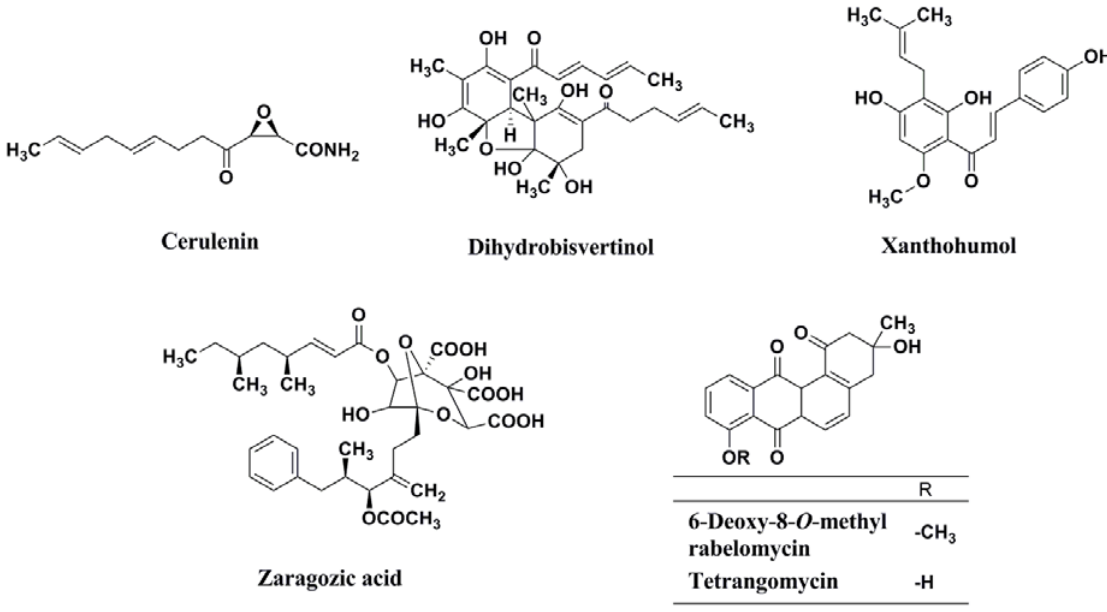
Figure 14. Structures of cerulenin, dihydrobisvertinol, xanthohumol, zaragozic acid, 6-deoxy-8- O -methylrabelomycin, and